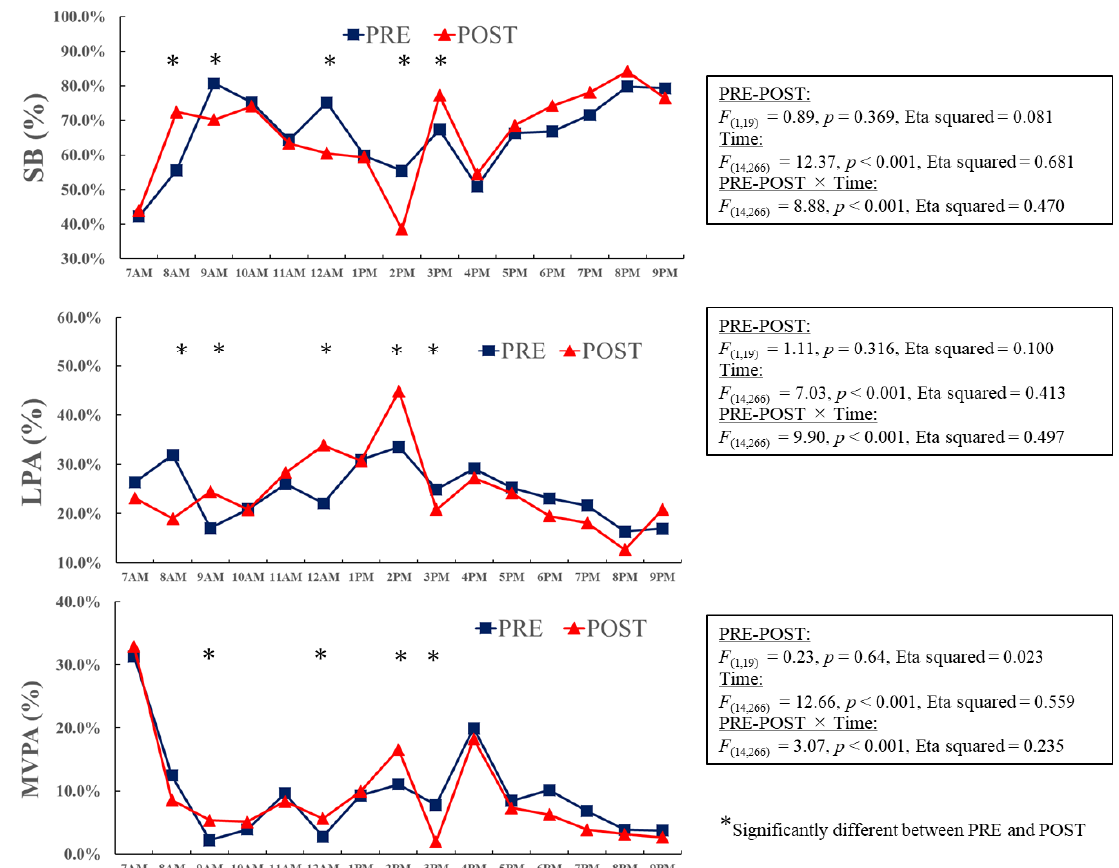
Figure 3. Hourly variations in activity levels in the control class at baseline and follow-up. Data are presented as percentages. Two-way ANOVA (PRE-POST × time) was performed to examine the hourly variations in activity levels in the control class at the baseline and follow-up. If the interaction was significant, post-hoc analysis was performed to examine the simple main effects in each hour.